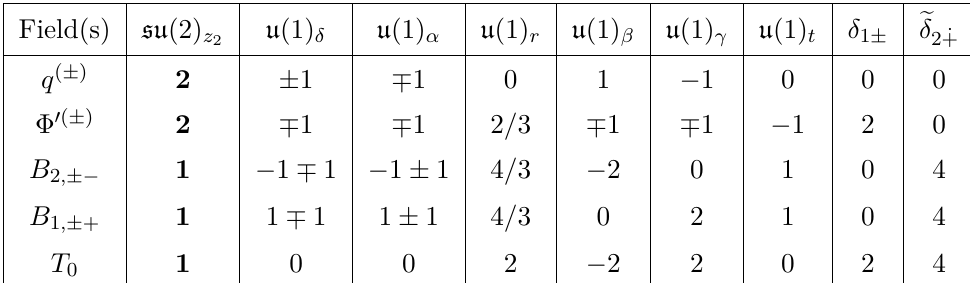
Table 7. Field content associated to the type B ‘quiver tail’ in Class S 2 corresponding to a sphere with two minimal punctures α, δ and a ‘pinched’ maximal puncture ( z glued to a maximal puncture to convert it to two minimal punctures. Each field is an N = 1 chiral multiplet. In the final columns we firstly list the value of δ q t of the corresponding field. e δ 2 ˙+ = 4 j 2 + 2 r + 4 3